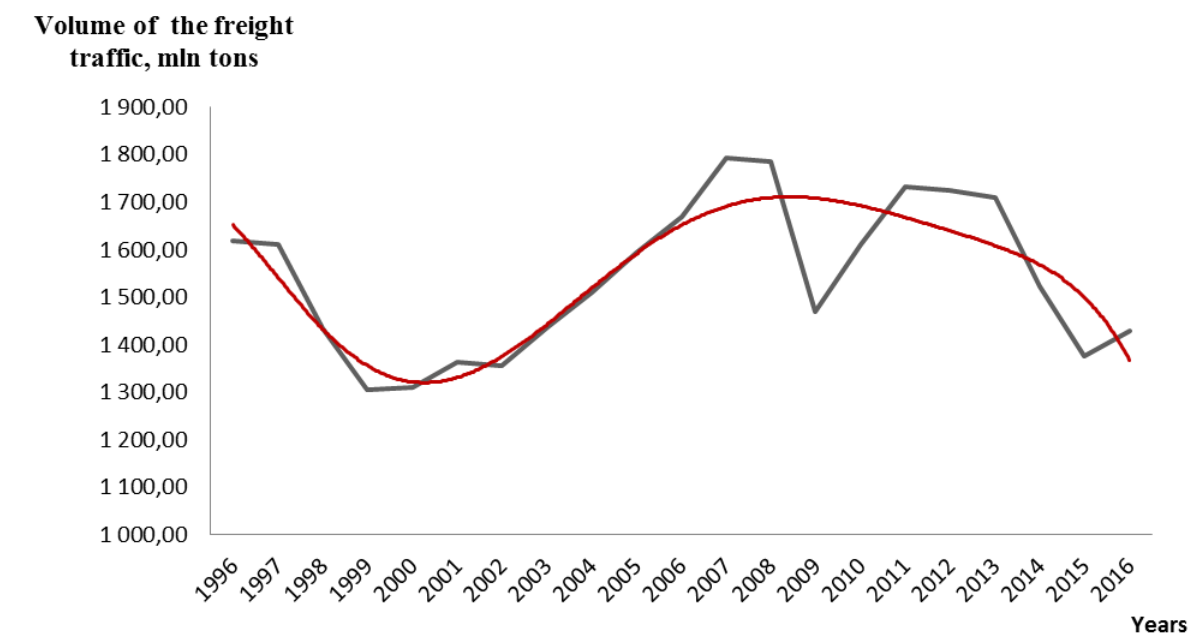
Fig. 2. Dynamics of the volume of freight traffic for 10